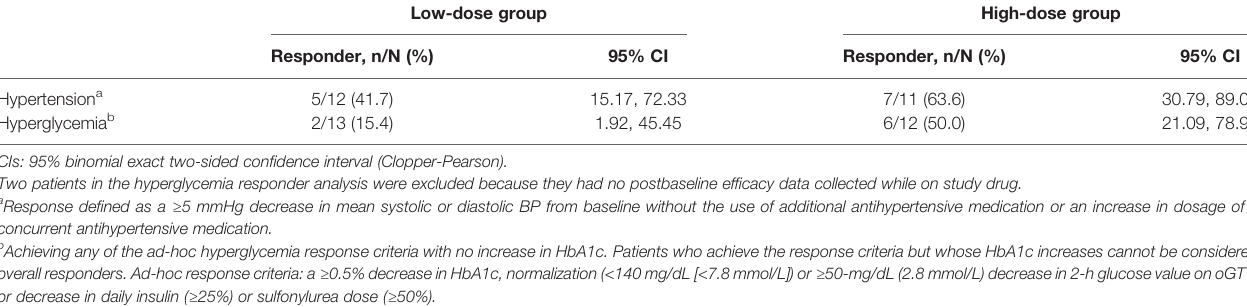
TABLE 3 | Summary of responder analysis in patients with hypertension (n = 23) and hyperglycemia (n = 25) at last observation. Low-dose group